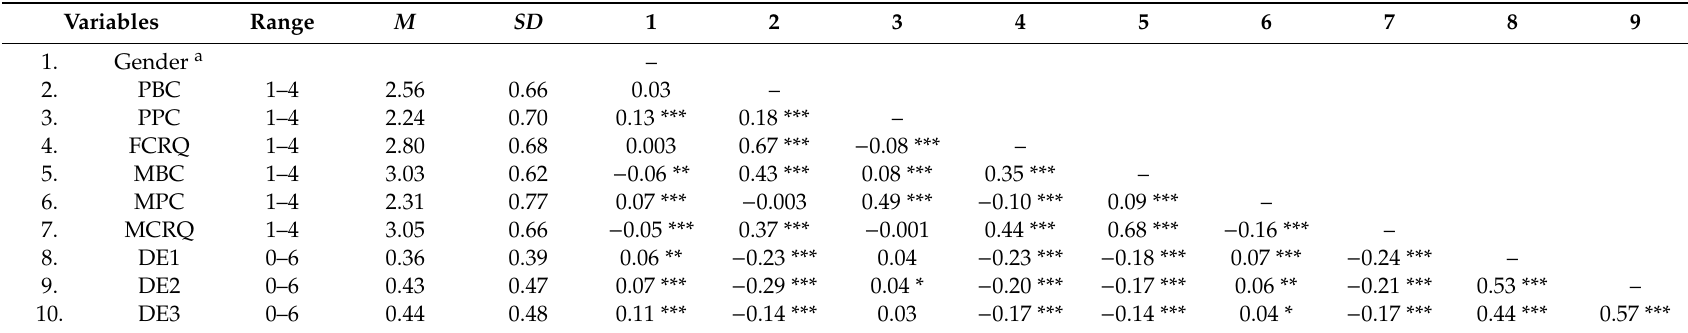
Table 3. Correlations among